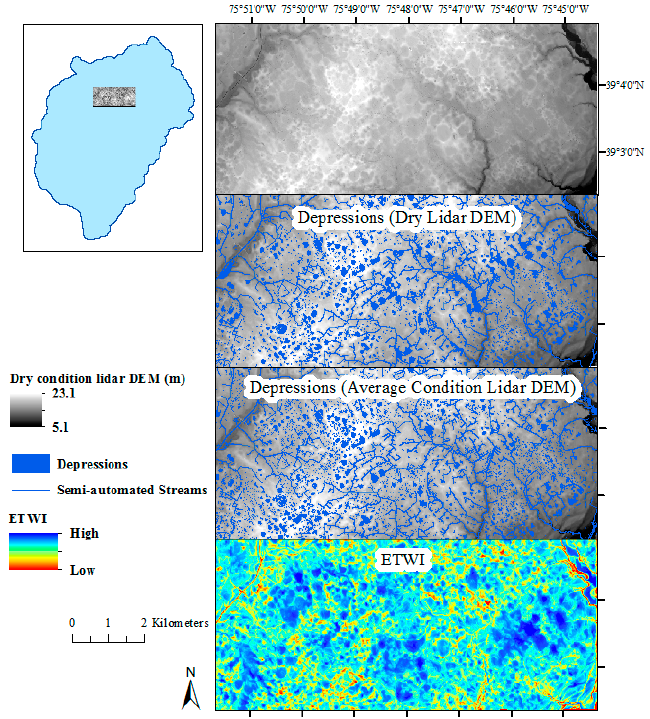
Figure 2. Depressions derived from the dry condition light detection and ranging (lidar) digital elevation model (DEM), average wetness condition lidar DEM, as well as the enhanced topographic wetness index (ETWI), derived from the dry condition lidar DEM. In the ETWI, areas more likely to be inundated are blue, areas more likely to be non-inundated are red. Extent is defined by the extent of the dry condition lidar DEM data collection.